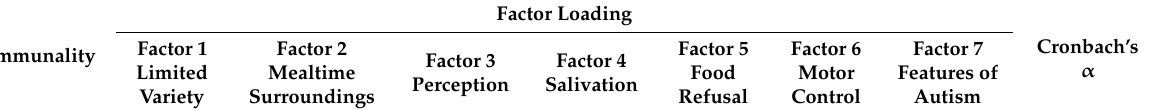
Table 4. Factor analysis of ASD students’ mealtime behavior.